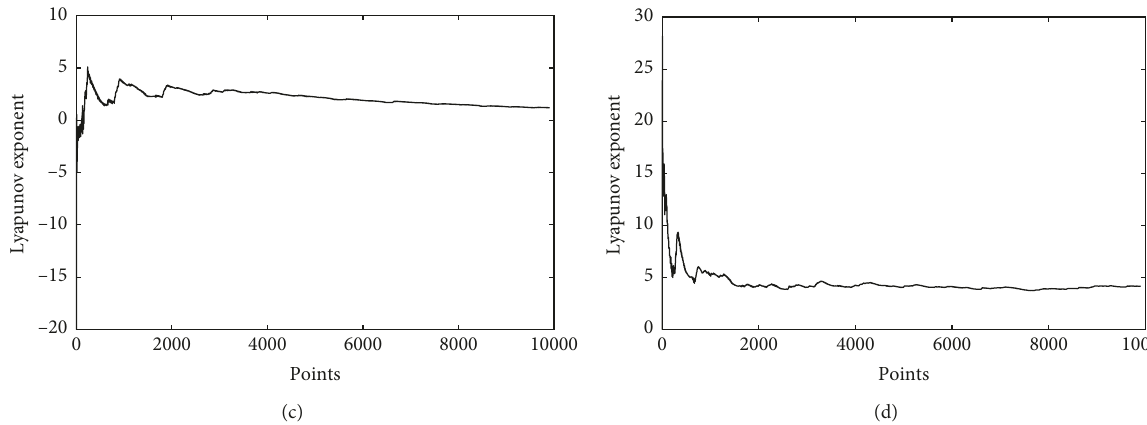
Figure 18: Lyapunov exponent of 2-DOF nine-bar mechanism for different driving speeds; (a) ω � − 1 . 5 π ( rad / s ) , ω (b) ω 1